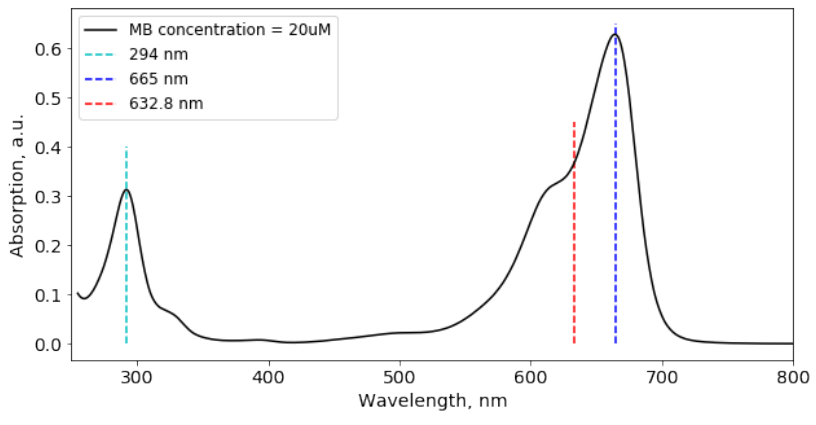
Figure 1. Absorption spectrum of